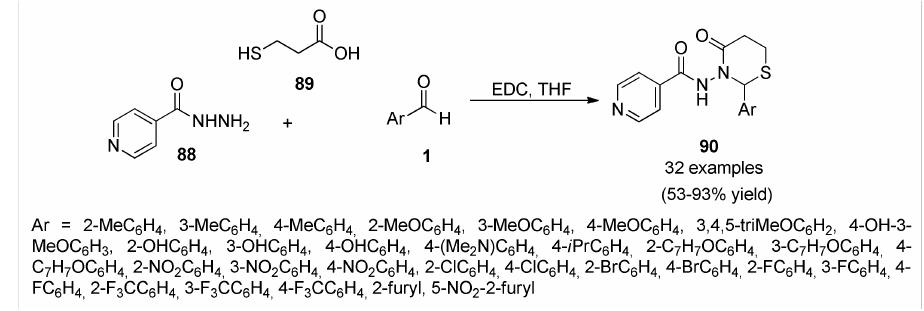
Scheme 37. Three-component synthetic protocol of compounds 90 as potential antitubercular